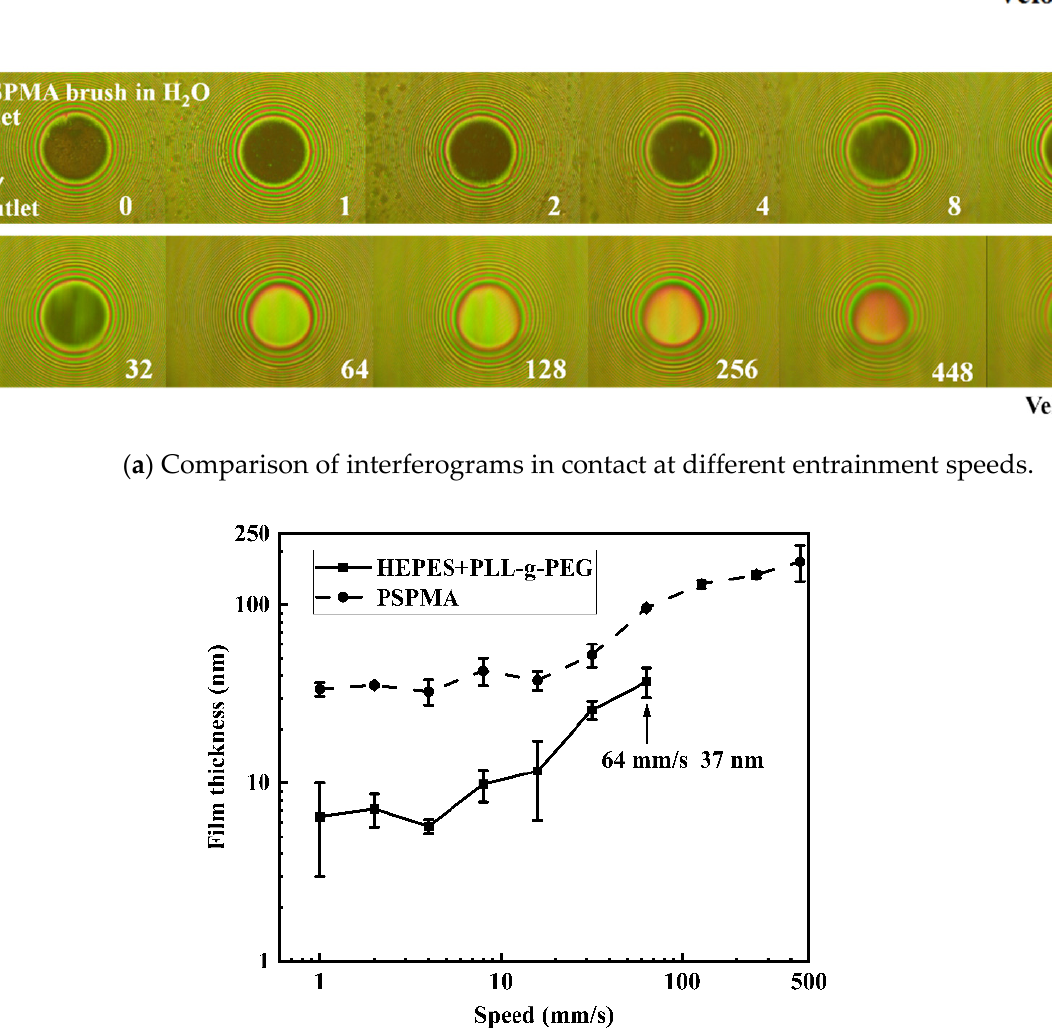
Figure 7. Comparison of interferograms and film thickness with entrainment speeds: from the light interferogram in ( a ), the film thickness value under the entrainment speed was measured, as shown in ( b ).